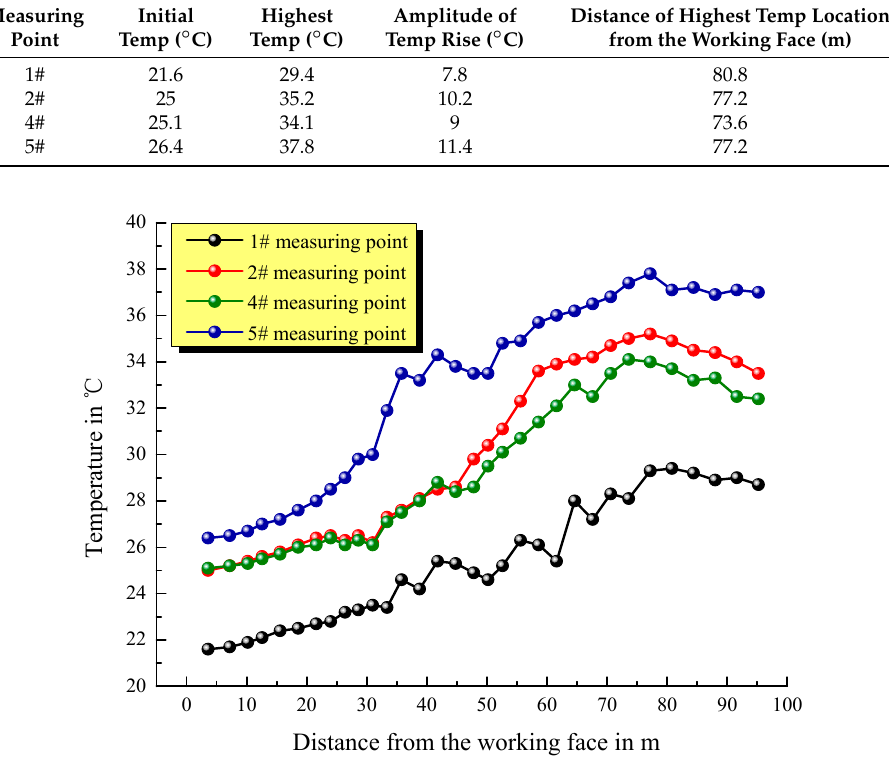
Figure 9. Temperature curve for #1, #2, #4, #5 measuring points.